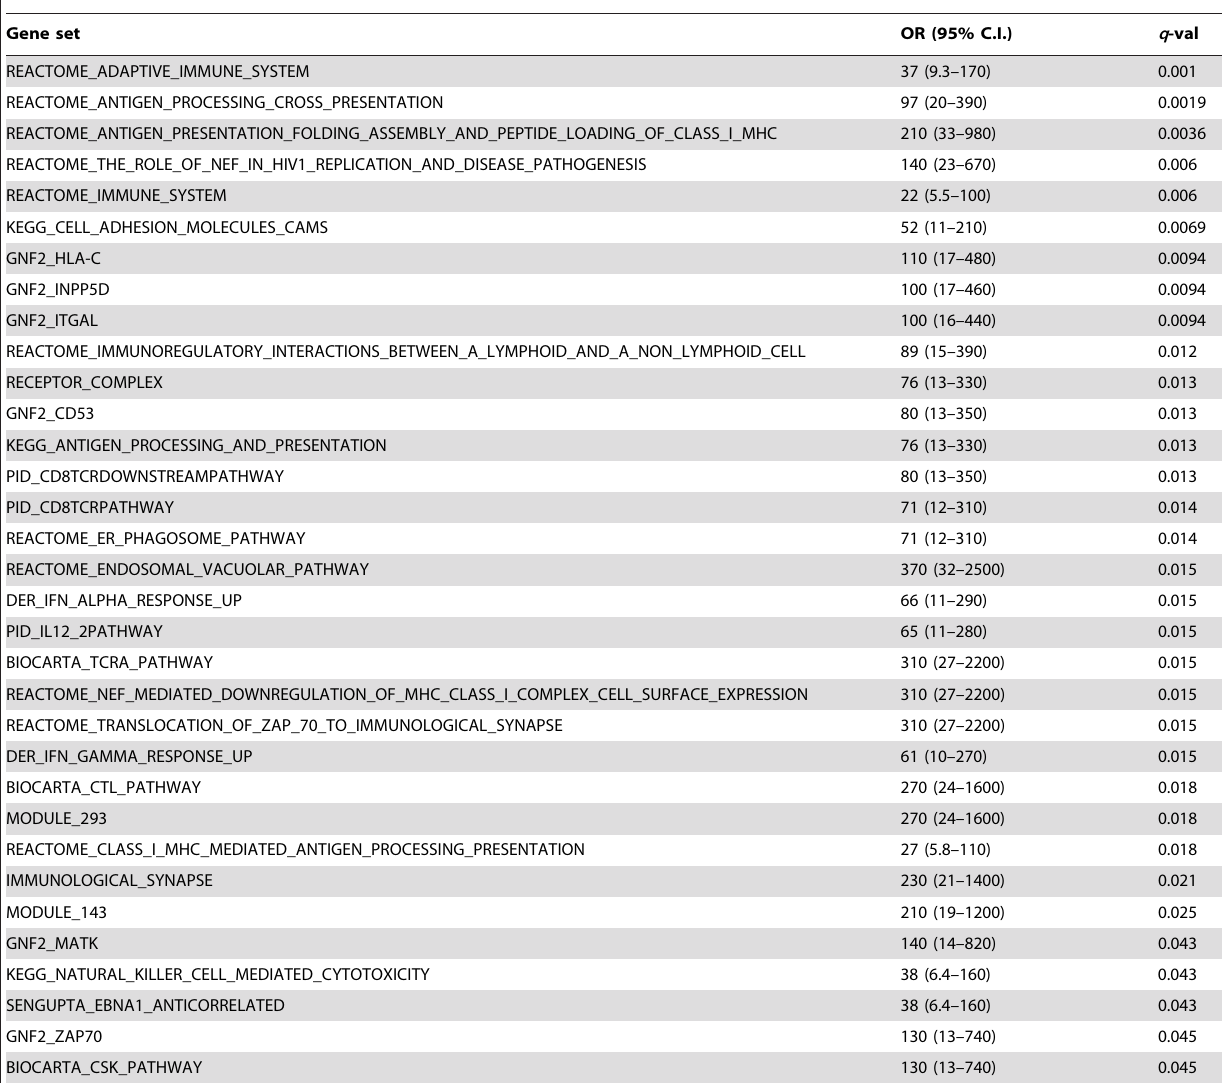
Table 9. Immune module: significantly enriched gene sets.